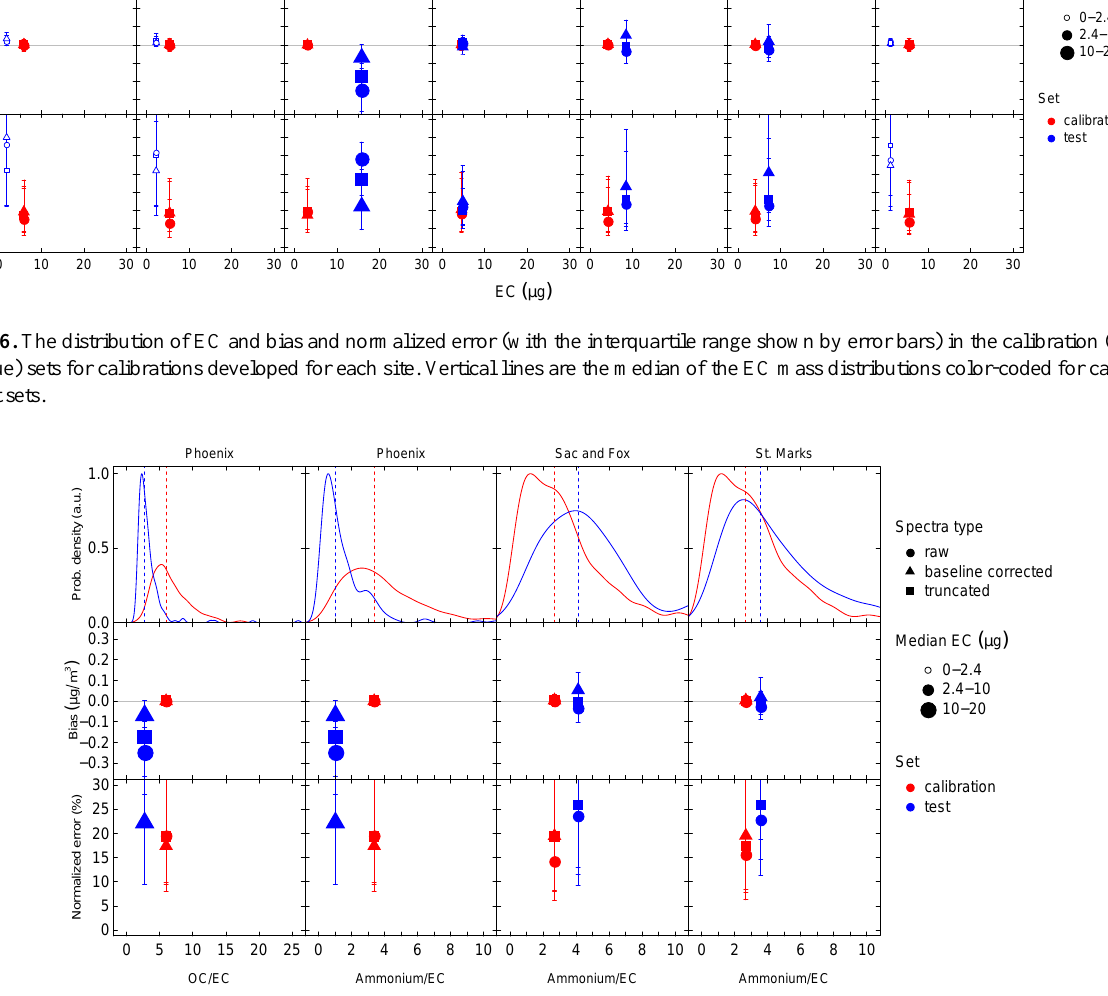
Figure 7. The distribution of OC/EC and bias and normalized error (with the interquartile range shown by error bars) in the calibration (red) and test (blue) sets for calibrations developed for Phoenix and the distribution of ammonium/EC, bias and normalized error for Phoenix, Sac and Fox and St. Marks. Vertical lines are the median of the distributions color-coded for calibration and test sets. compared to the calibration set likely due to ammonium/EC